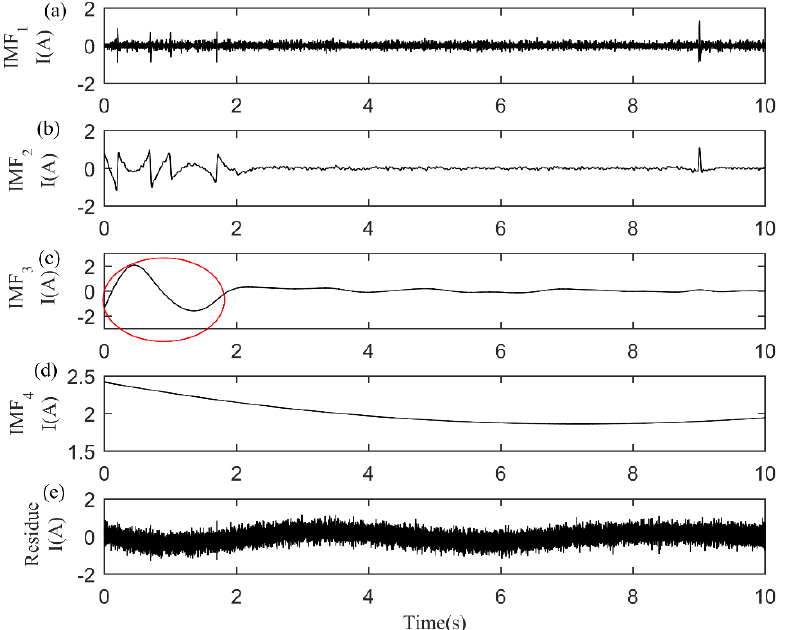
Figure 14. EEMD decomposition diagram under the noise of SNR 10. ( a ) IMF 1 component; ( b ) IMF 2 component; ( c ) IMF 3 component; ( d ) IMF 4 component; ( e ) Residue.